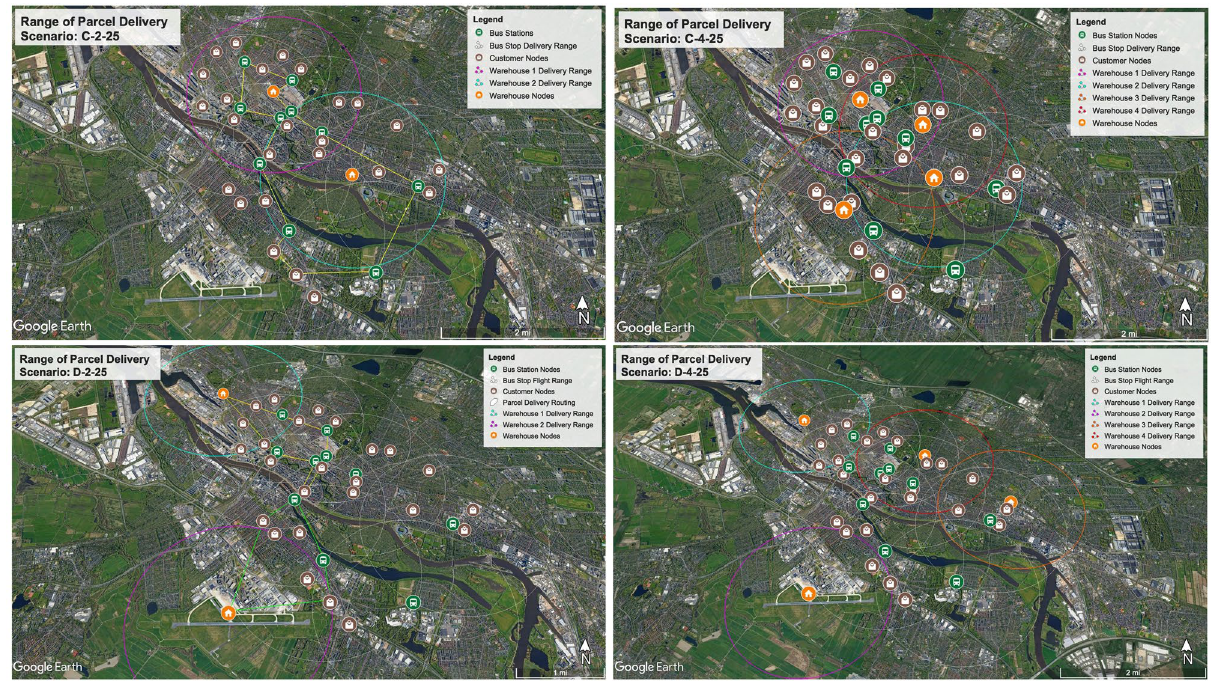
Figure 6. The flight range of delivery drones under four scenarios with 25